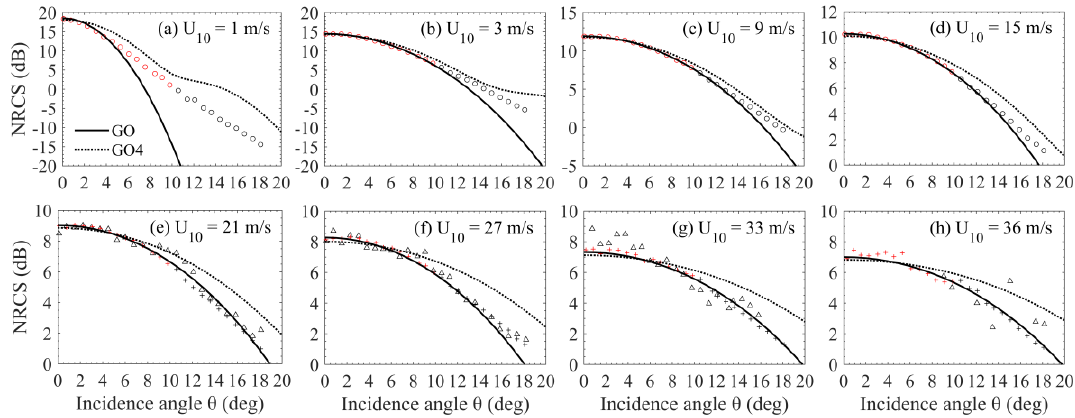
Figure 7. Least squares fits of the classical geometrical optics GO (solid lines) and improved geometrical optics GO4 (dotted lines) models and their comparison with measurements at selected wind speeds. Circles represent the satellite / buoy data; triangles are the satellite / SFMR data; and pluses are the satellite / H*Wind data. Red indicates that the data are used for the fits.